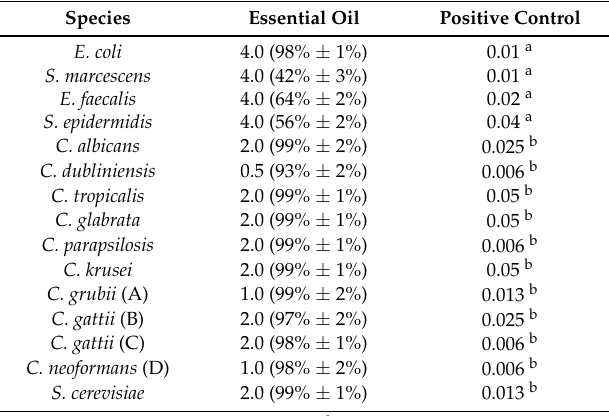
Table 4. Minimum inhibitory concentrations (MIC) for essential oil from L. alba . Concentrations are given in mg/mL. Numbers in parentheses denote the percentage of growth inhibition and its standard